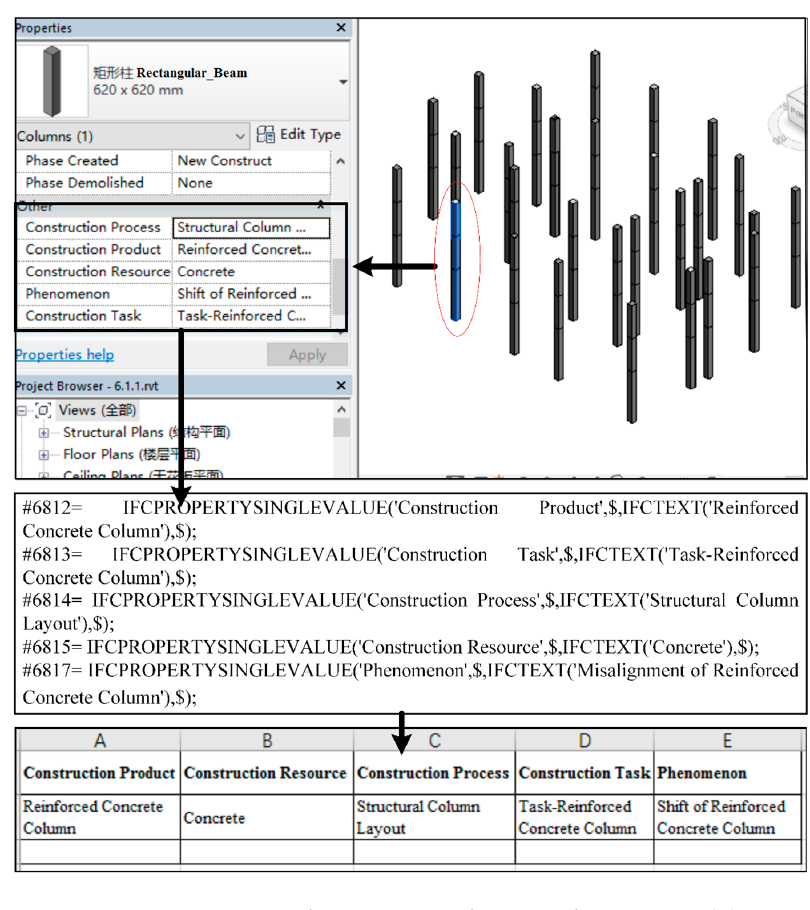
Figure 12. Extraction of construction information from BIM model.